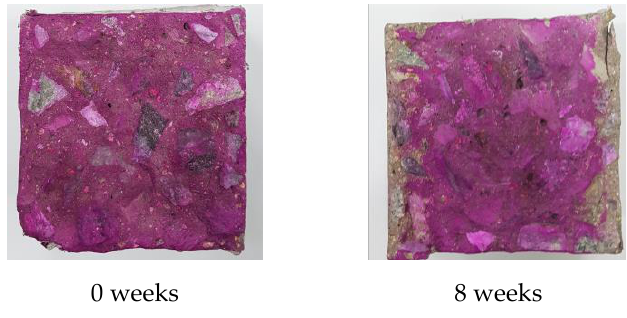
Figure 6. Carbonation test results for FA15.